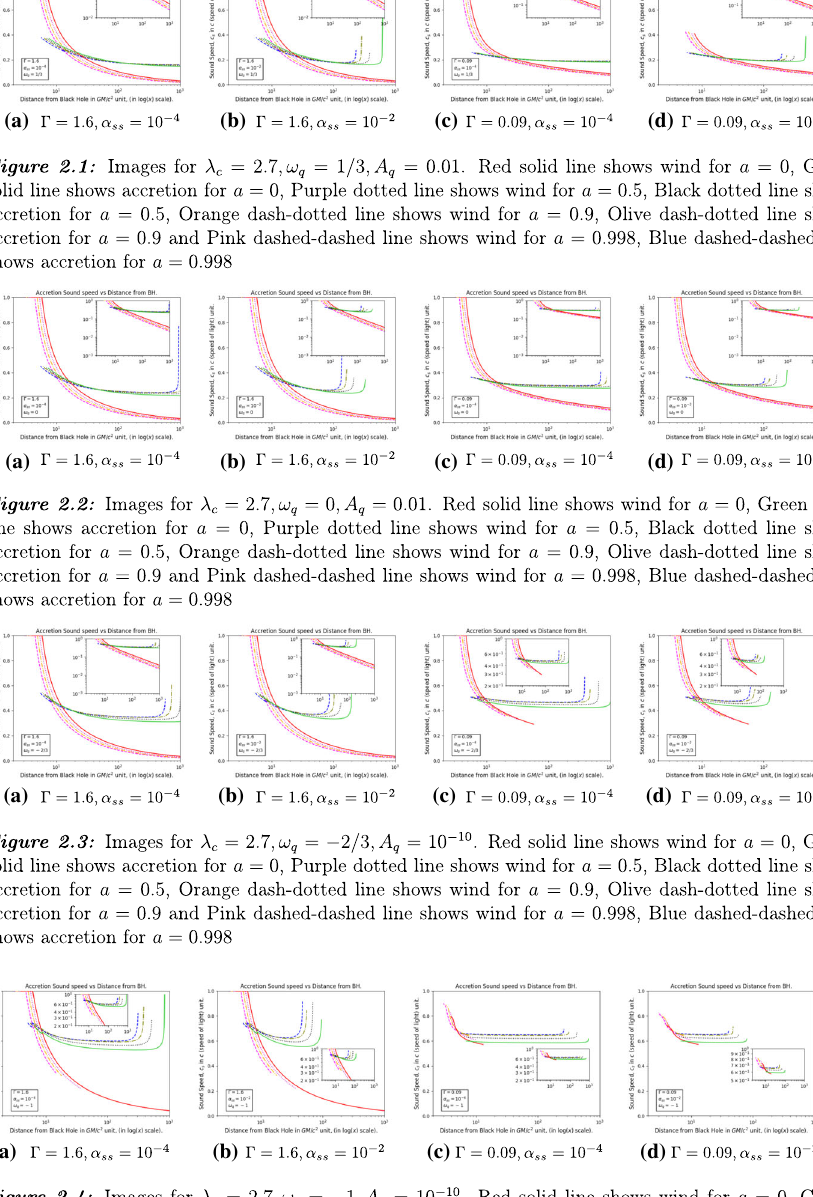
2.3 Images for λ c = 2 . 7 ,ω q = − 2 / 3 , A q = 10 − 10 . Red solid line shows wind for a = 0, Green solid line shows accretion for a = 0, Pur- ple dotted line shows wind for a = 0 . 5, Black dotted line shows accre- tionfor a = 0 . 5,Orangedash-dottedlineshowswindfor a = 0 . 9,Olive dash-dotted line shows accretion for a = 0 . 9 and Pink dashed-dashed line shows wind for a = 0 . 998, Blue dashed-dashed line shows accre- tion for a = 0 . 998. 2.4 Images for λ c = 2 . 7 ,ω q = − 1 , A q = 10 − 10 . Red solid line shows wind for a = 0, Green solid line shows accretion for a = 0, Purple dotted line shows wind for a = 0 . 5, Black dotted line shows accretion for a = 0 . 5, Orange dash-dotted line shows wind for a = 0 . 9, Olive dash-dotted line shows accretion for a = 0 . 9 and Pink dashed-dashedlineshows windfor a = 0 . 998, Bluedashed-dashedline shows accretion for a = 0 . 998